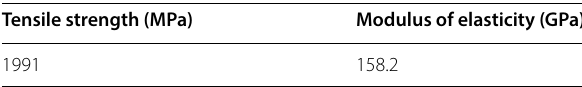
Table 6 Properties of